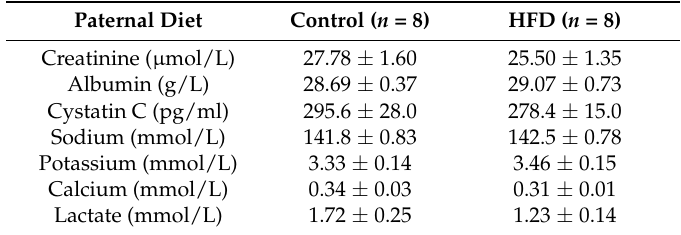
Table 2. Plasma creatinine, albumin, cystatin C and electrolyte